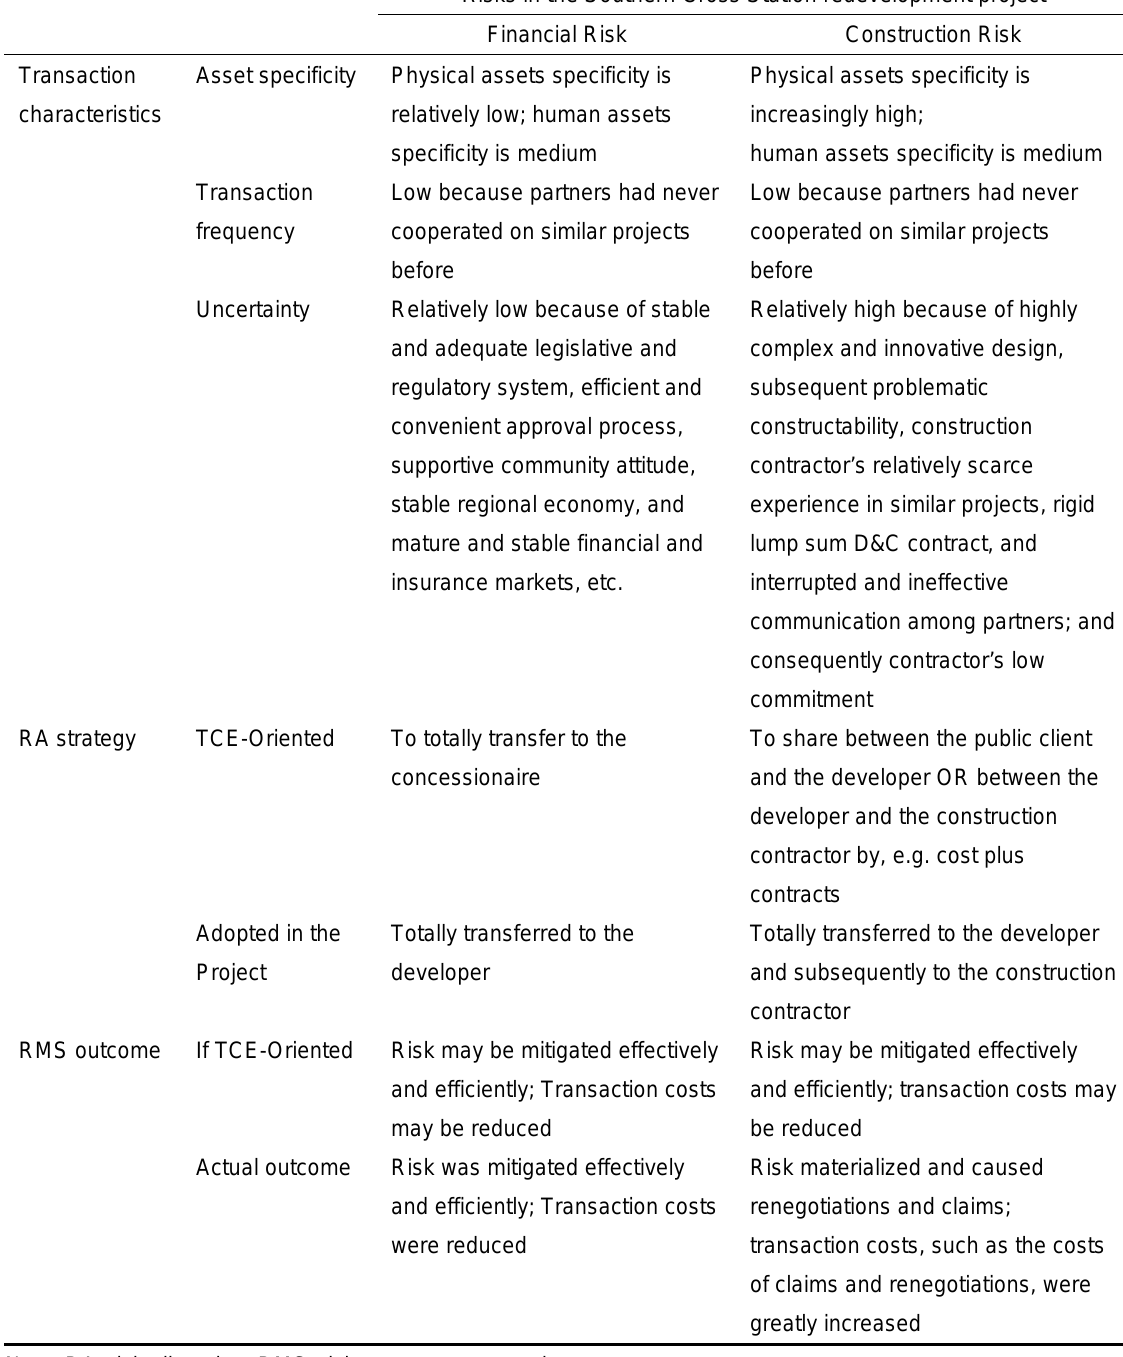
Table 1: RMS transactions and TCE-orientated recommendations for the Southern Cross Station redevelopment